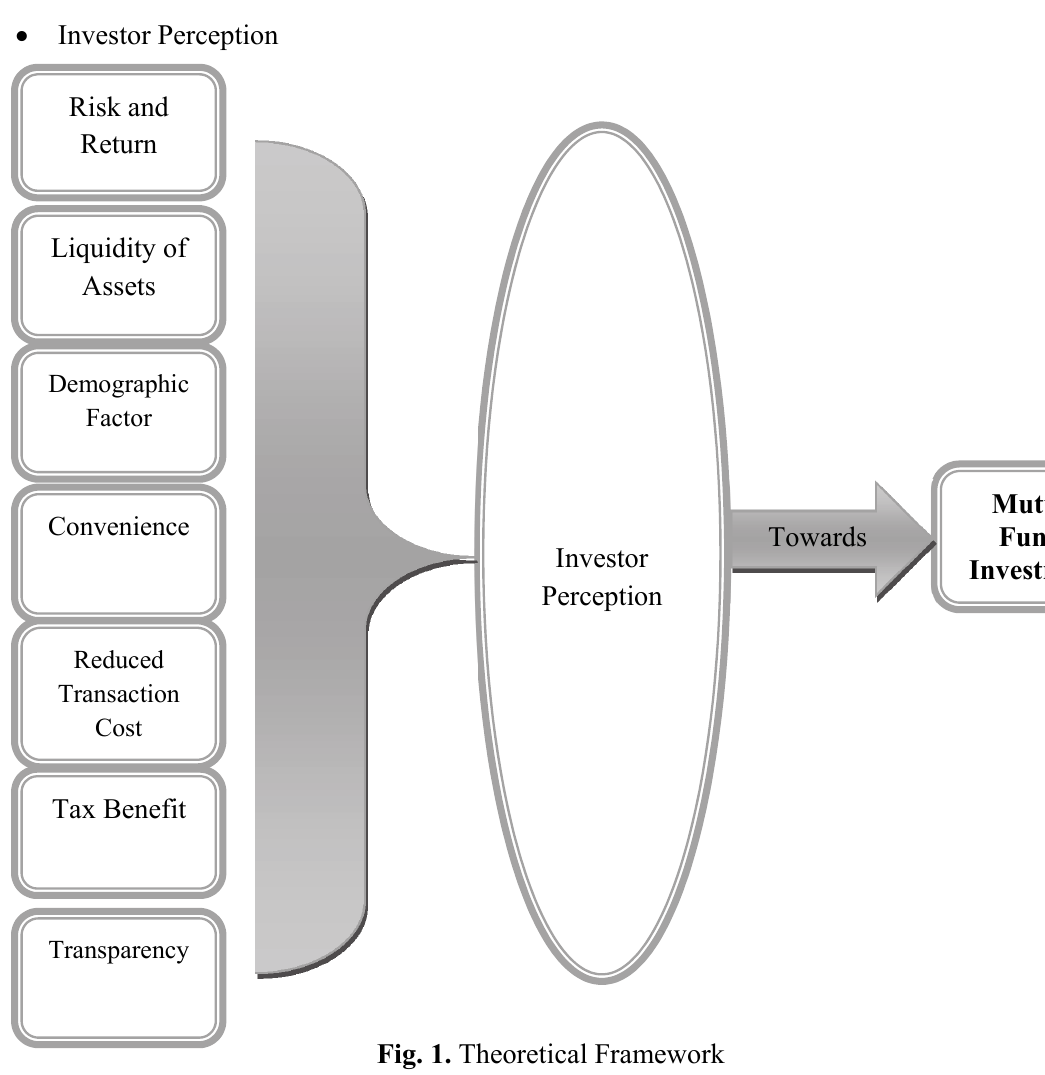
Fig. 1. Theoretical